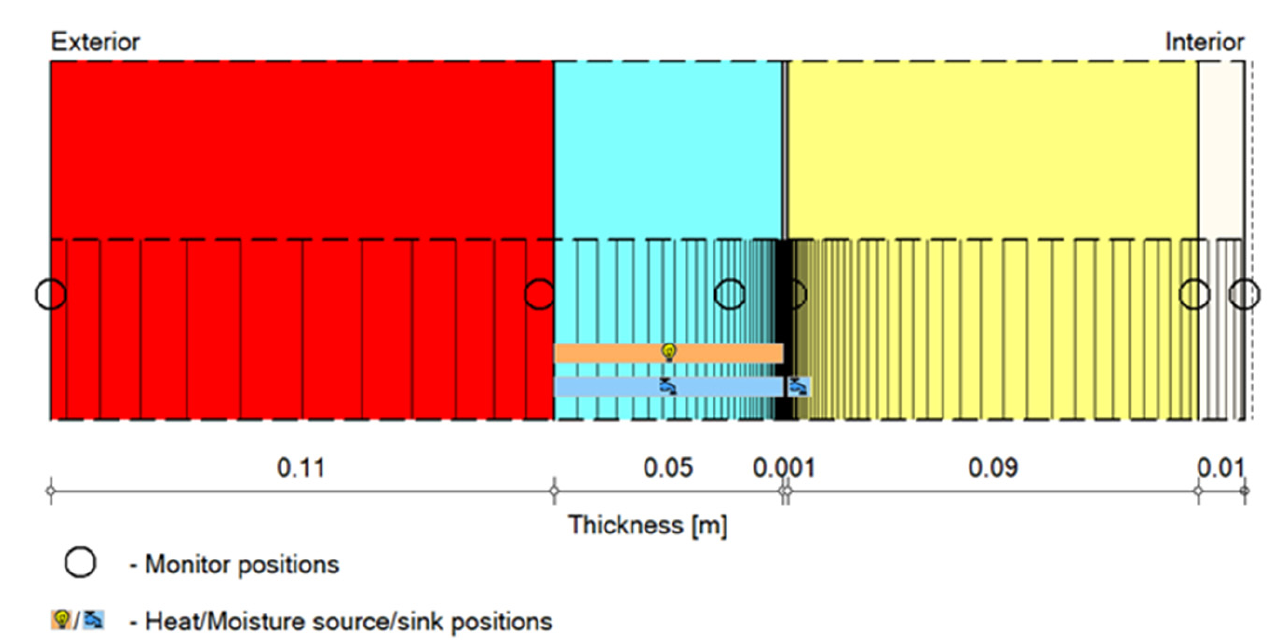
Figure 6. Simulation layers of the wall assembly with their camera positions.